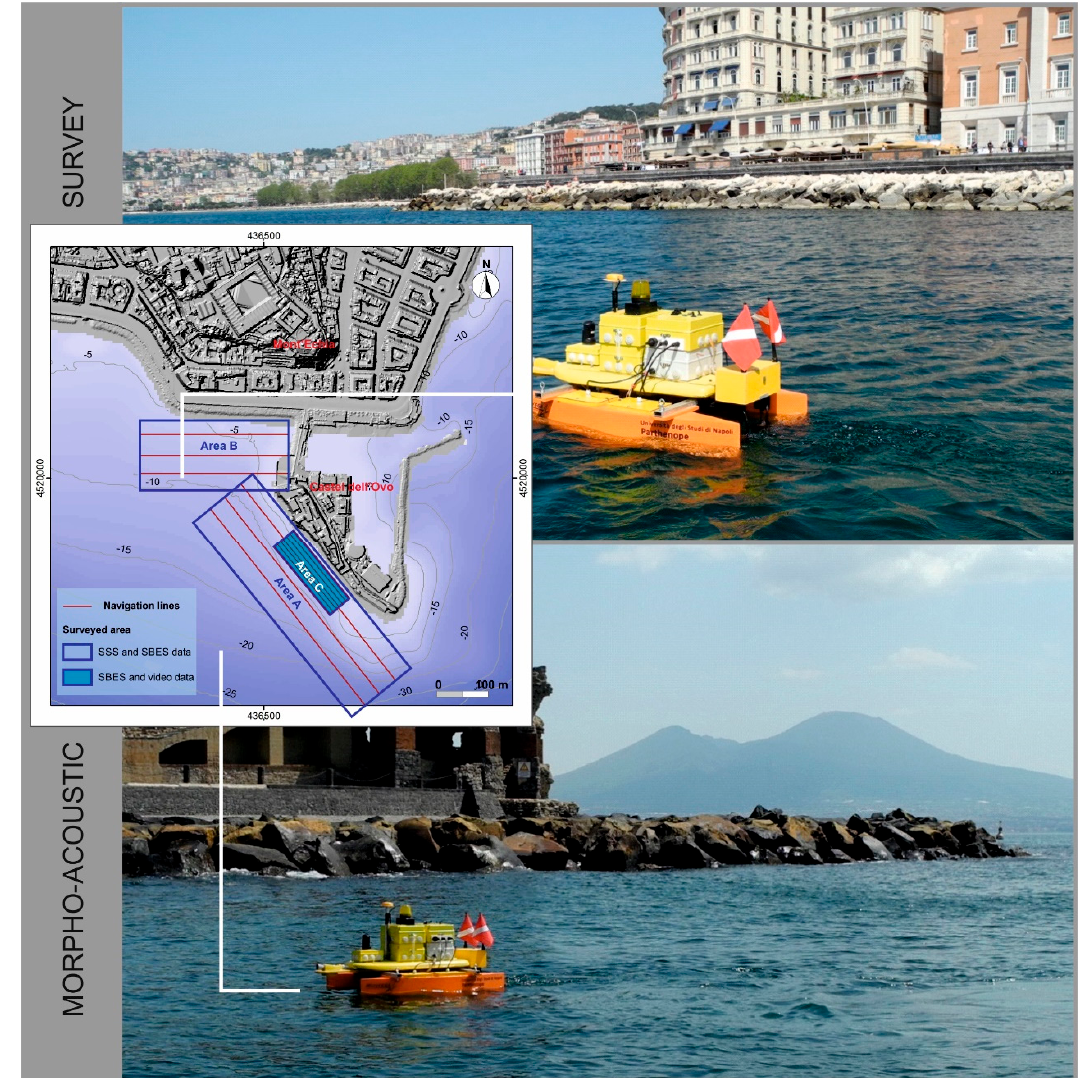
Figure 3. MicroVeGA survey in the marine area off Castel dell’ Ovo (photos taken by the authors during the surveys).